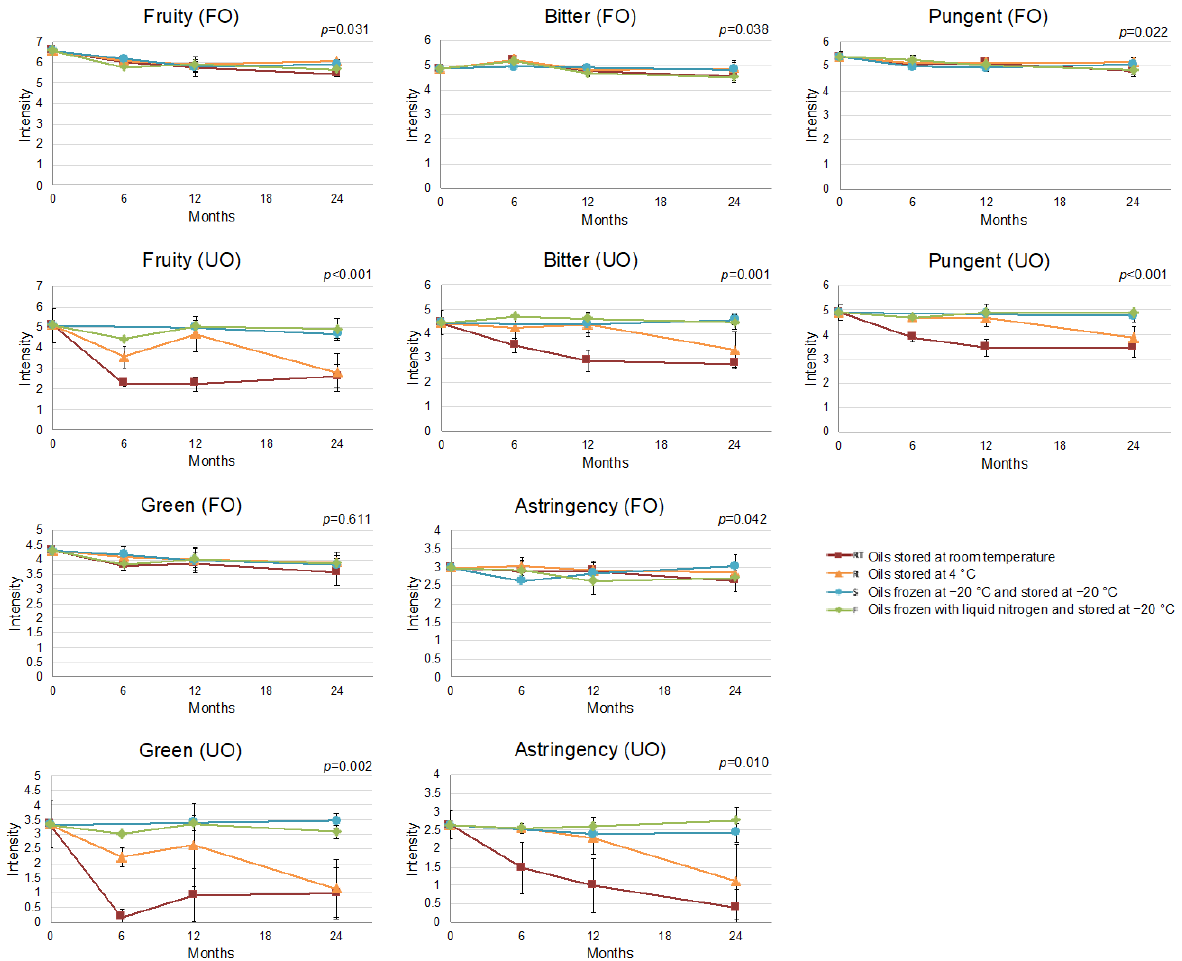
Figure 5. Interaction plot between storage conditions and time for the positive sensory attributes fruity, bitter, pungent, green and astringency of the filtered (FO) and the unfiltered (UO) oils over storage under different conditions. p ≤ 0.05 indicates significant interaction between the two factors (storage conditions and storage time). Error bars correspond to the standard deviation.